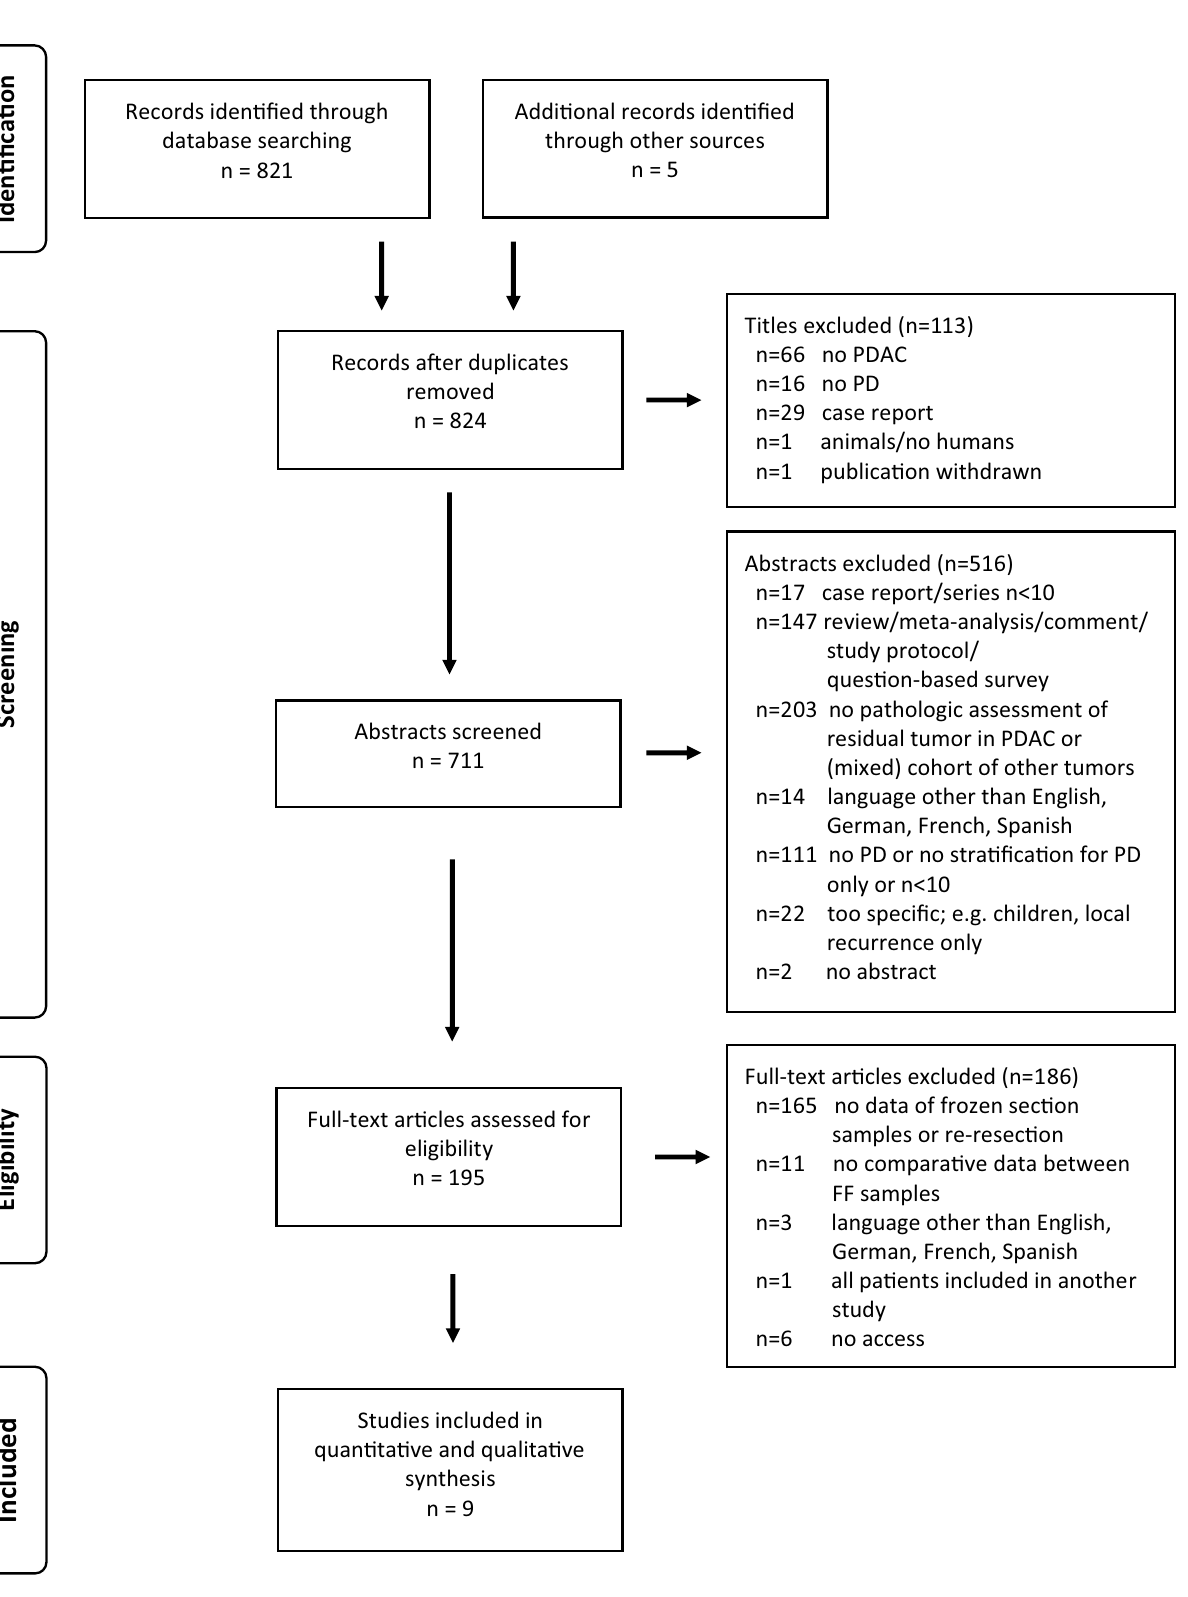
Figure 1. PRISMA flow